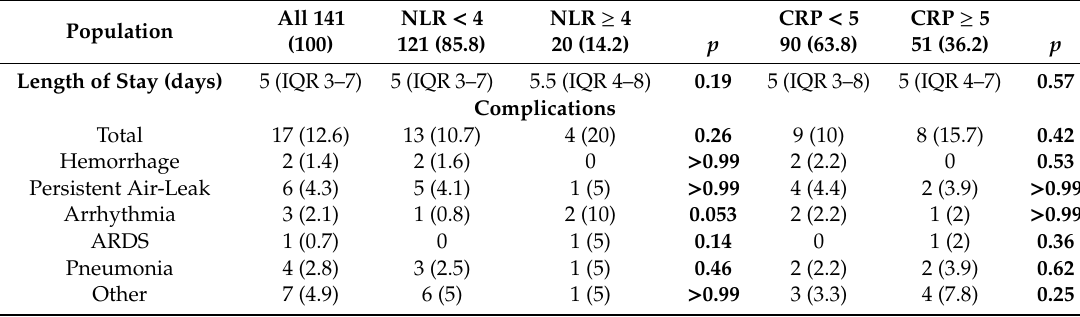
Table 3. Postoperative outcomes.